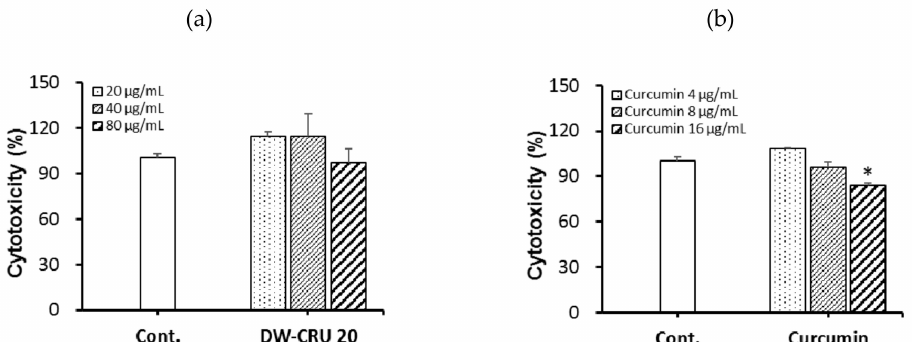
Figure 4. Cytotoxicity of DW-CUR 20 in HepG2 cells. Cell viability was determined using the EZ-CYTOX cell viability kit. Cells were pretreated with the indicated concentrations of ( a ) DW-CUR 20 (20, 40, and 80 µ g / mL) or of ( b ) curcumin (4, 8 and 16 µ g / mL) for 12 h. Data shown represent mean ± SD of triplicate experiments. * p < 0.05 vs. the control group.